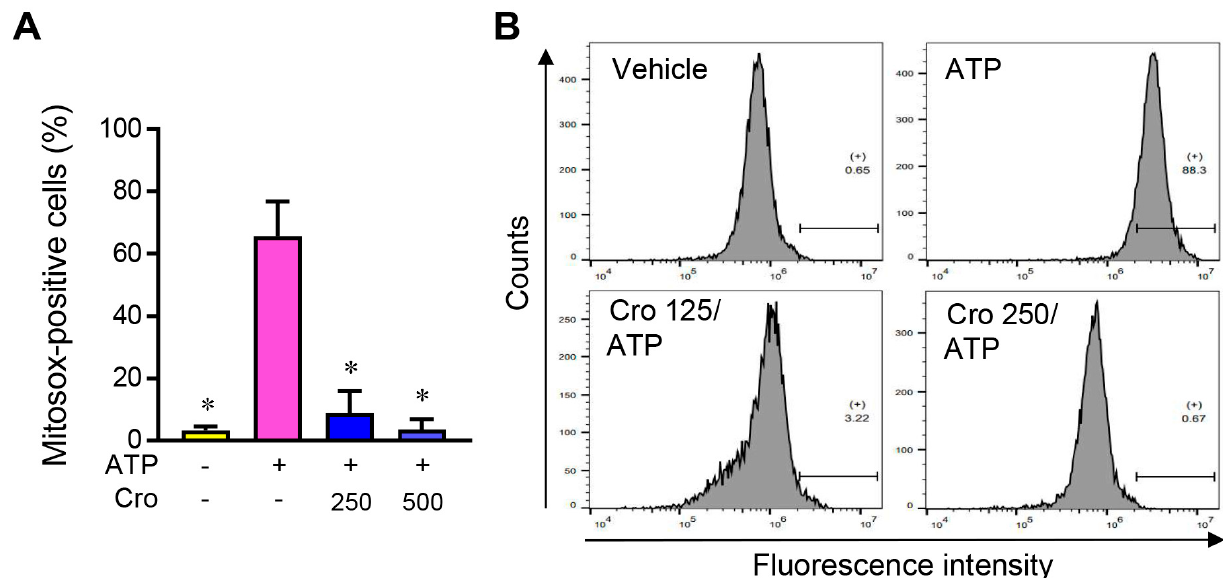
Figure 6. Effects of Crocin on mtROS production and mitochondrial membrane potential. ( A ) LPS- primed J774A.1 cells were pretreated with Crocin (125 μ M or 250 μ M) for 3 h, and then incubated with ATP (5 mM) for 1 h. Cells were then incubated with MitoSOX for 10 min, and mitochondrial ROS were determined by flow cytometry. ( B ) Representative flow cytometry histograms. The data are expressed as the mean ± SEM and represent three experiments. * p < 0.05 vs. group treated with ATP.